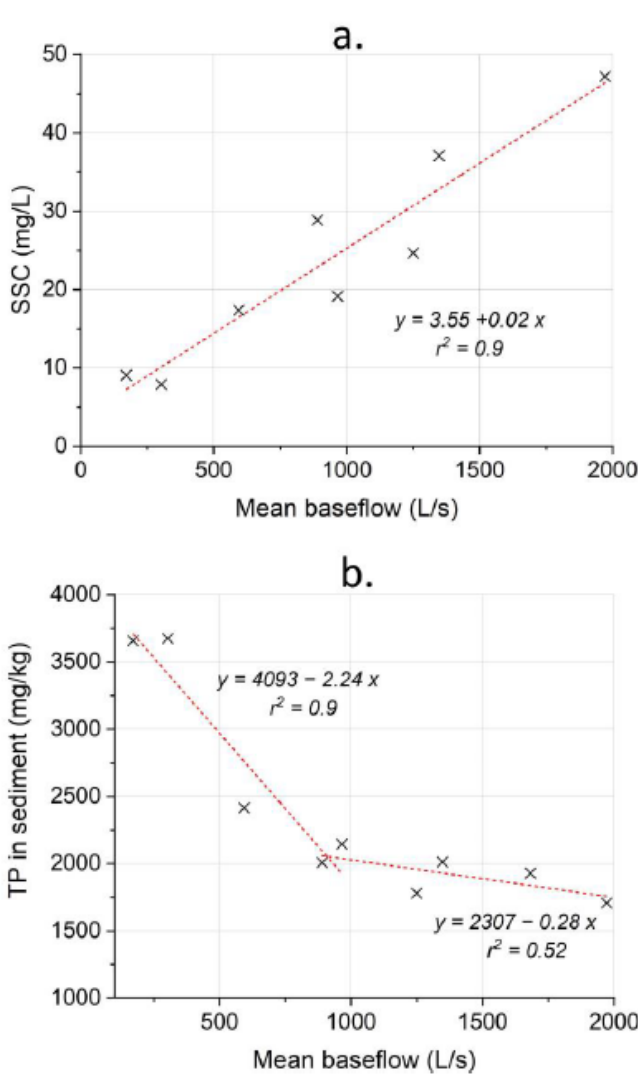
Figure 11. ( a ) SSC rating curve for low flow conditions. ( b ) Relation between mean baseflow and TP in the suspended solids (sediment in the tank).